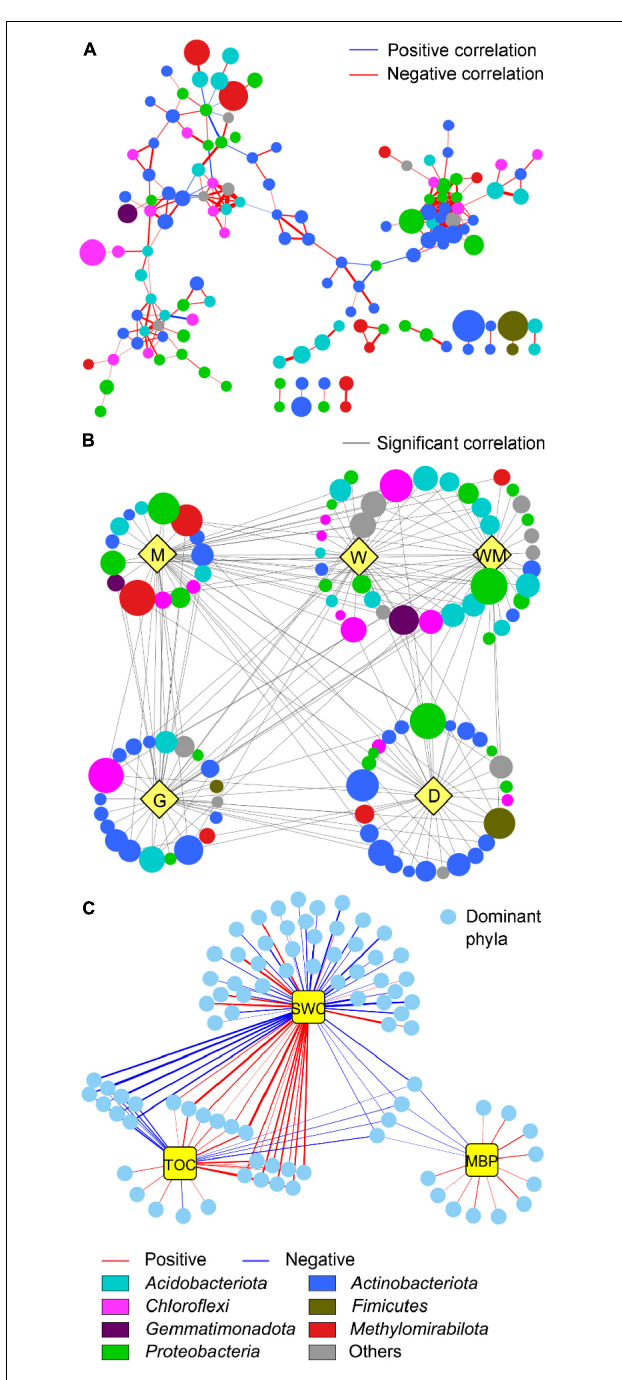
FIGURE 6 | Co-occurrence networks of soil microbial communities across five wetland degradation gradients together (A) and individually (B) and their interactions with soil physicochemical properties (C) . The network can be organized into five groups according to the occurrence of different taxa in different gradients (indicated with yellow nodes in (B) : typical wetland (W), wet meadow (WM), meadow (M), grassland (G), and desert (D). Gray edges in (B) indicate co-occurrence of taxa in different degradation gradient groups. Nodes are colored by different dominant phyla in (A,B) . Yellow nodes in (C) indicate soil properties, including soil water content (SWC), total organic carbon (TOC), and microbial biomass P